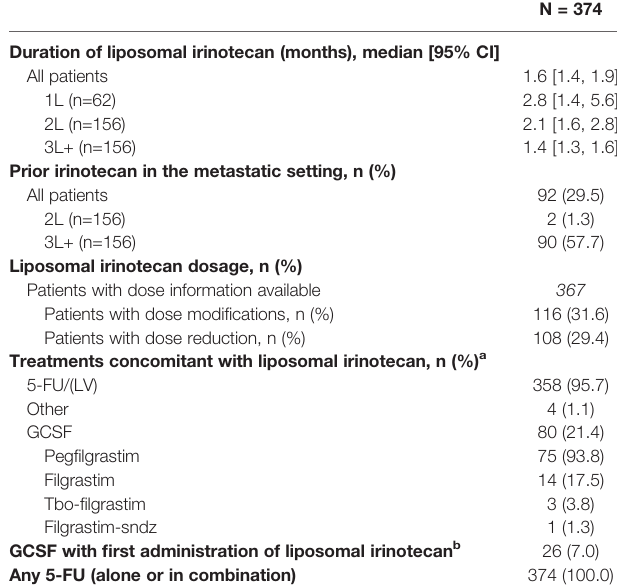
TABLE 2 | Treatment patterns in the metastatic setting prior to liposomal irinotecan-based treatment.